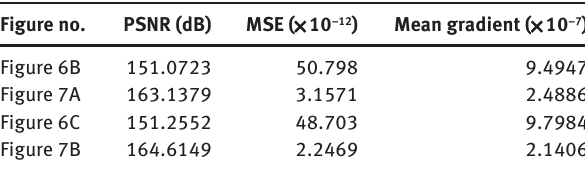
Table 3: Quality parameters of different images. Figure